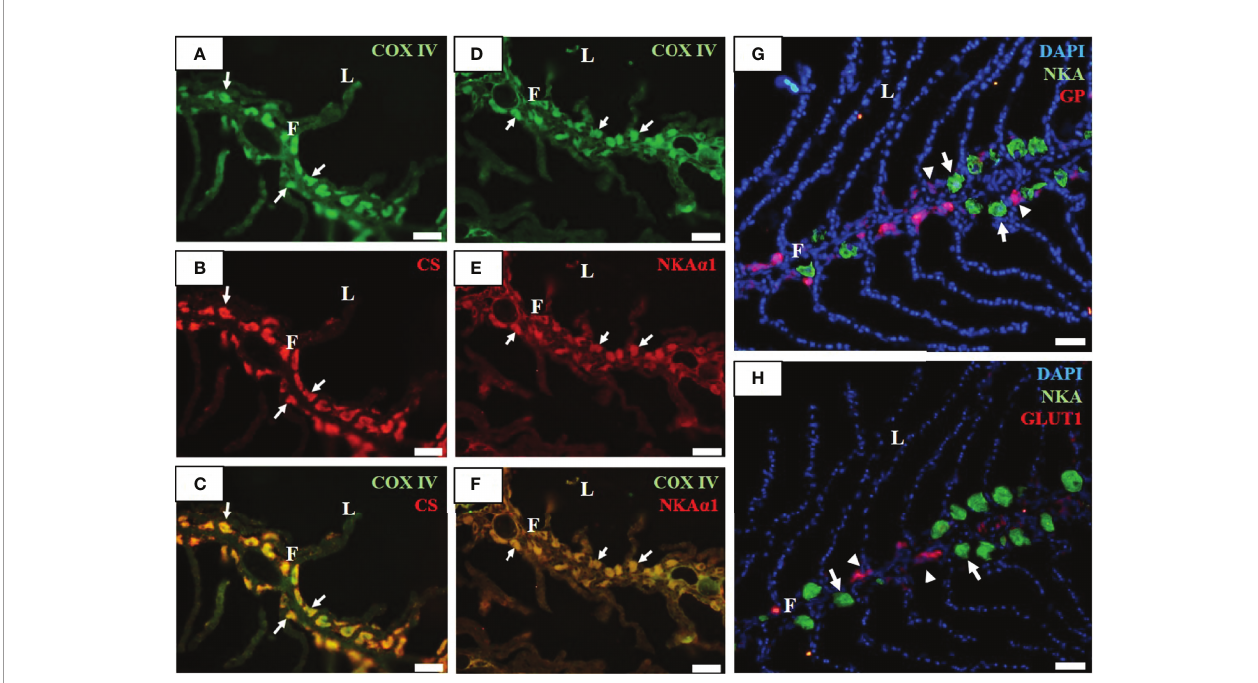
FIGURE 1 | Immuno fl uorescence staining of gill fi laments of milk fi sh stained with anti-cytochrome c oxidase (COX IV, green; (A, D) , citrate synthase (CS, red; (B) , sodium-potassium ATPase a 1 subunit (NKA a 1, red; (E) , glycogen phosphorylase (GP, red; (G) , sodium-potassium ATPase a subunit (NKA, green; (G, H) , and glucose transporter 1 (GLUT1, red; (H) antibodies. Immunoreactions for the merged images (C) and (F) are shown from COX IV (A) with CS (B) , and COX IV (D) with NKA a 1 (E) , respectively. F, fi lament; L, lamella. Scale bar, 50 m